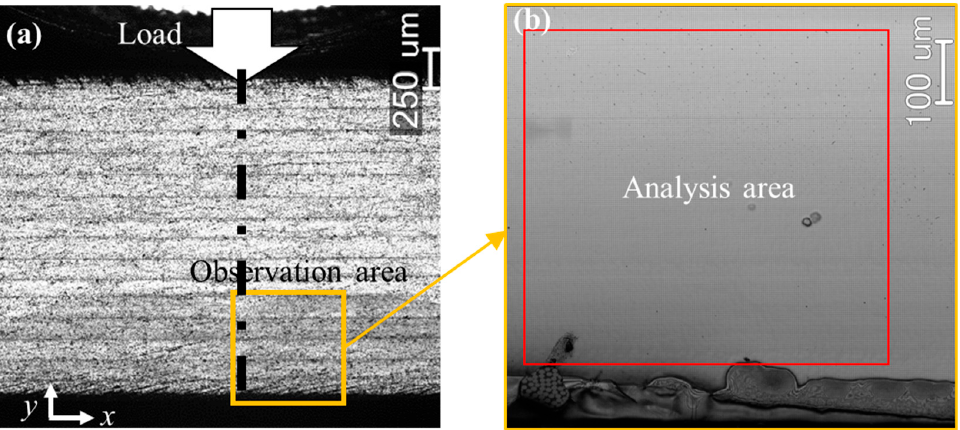
Figure 6. Surface images showing ( a ) the observation area and ( b ) the analysis area on CFRP specimen during three-point bending test.